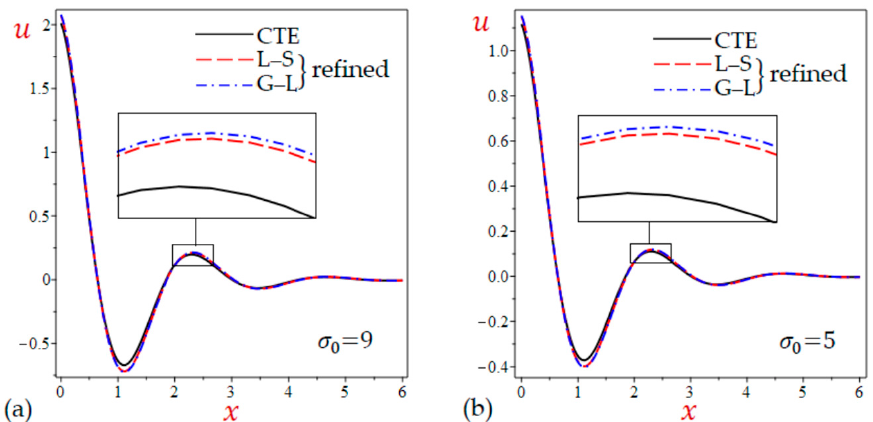
Figure 9. Effect of initial stress σ 0 on the horizontal displacement u of the rotating half-space without